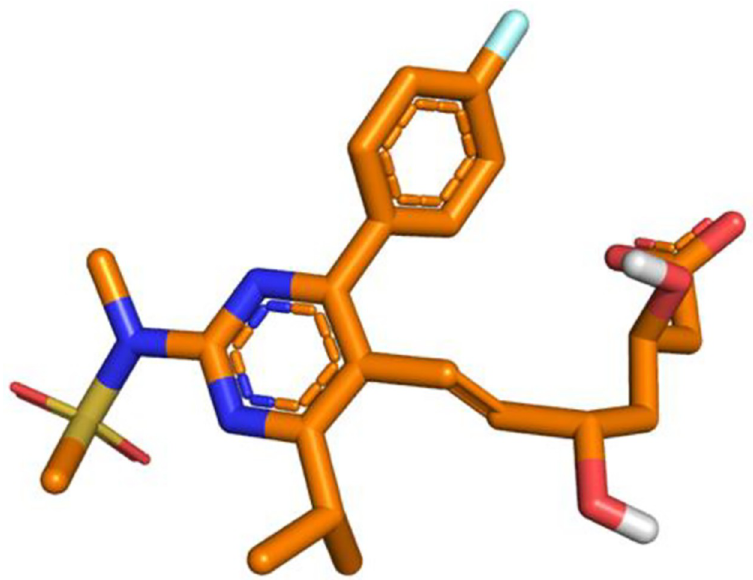
Fig 1. Rosuvastatin 3D structure. In orange are shown the carbon atoms, blue the nitrogen atoms, yellow the sulphur atom, in cyan the fluorine atom and the polar oxygen and hydrogen atoms in red and white, respectively.